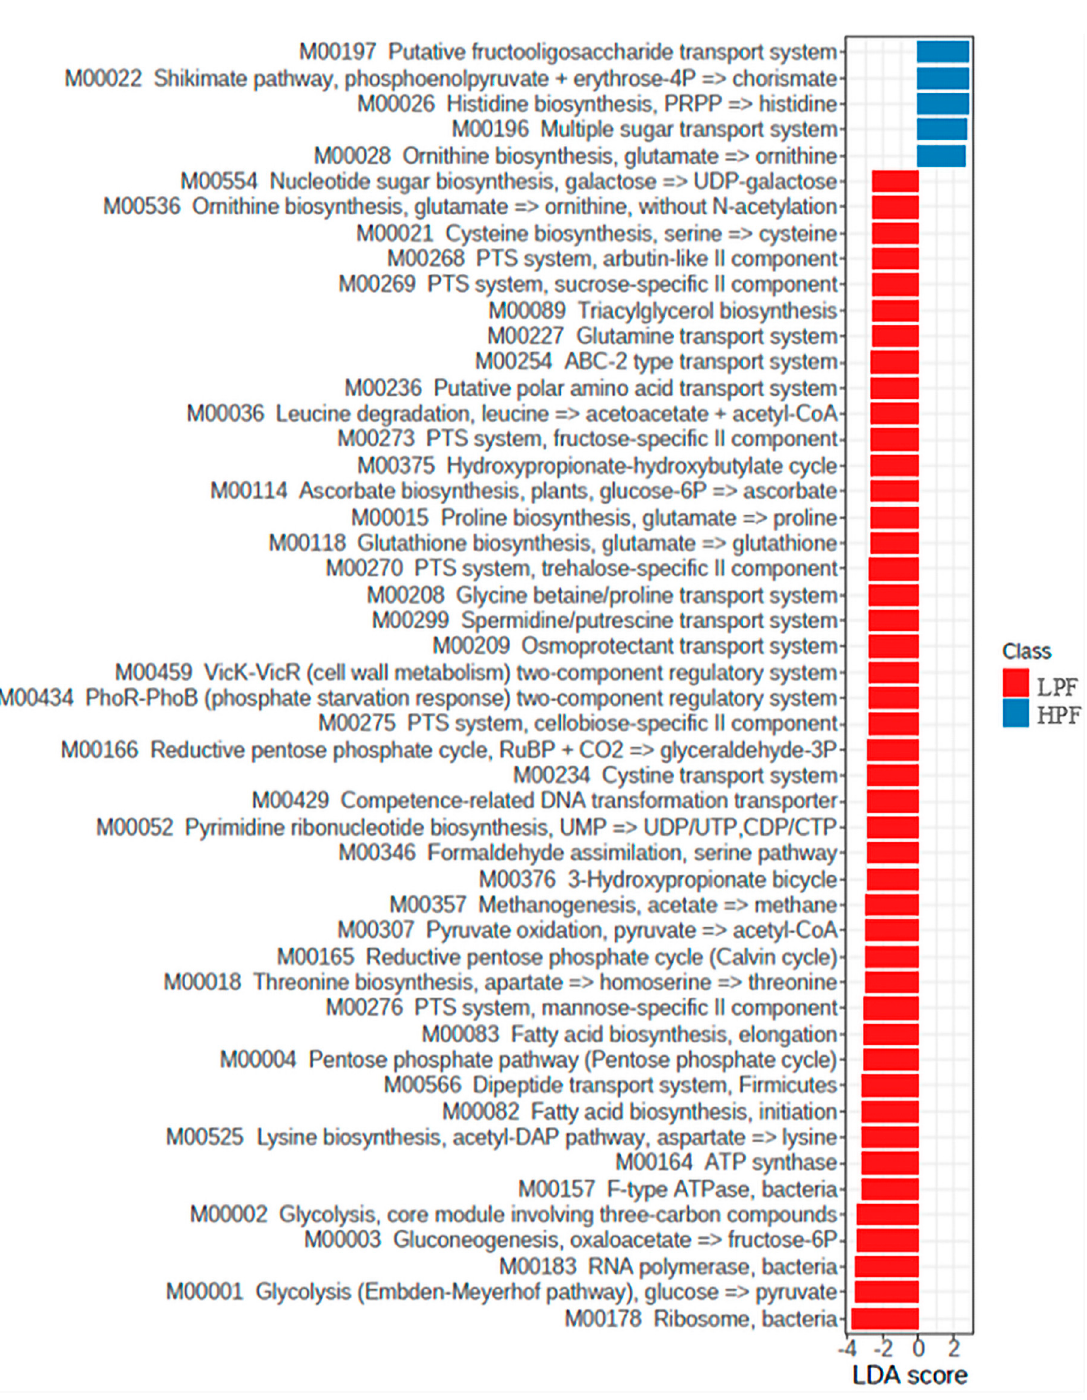
dipeptide transport systems (M00435, M00236, M00234, and M00566). Regarding KO